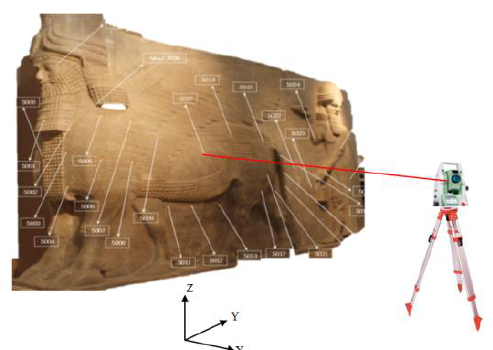
Figure 12. Measuring the reference points.